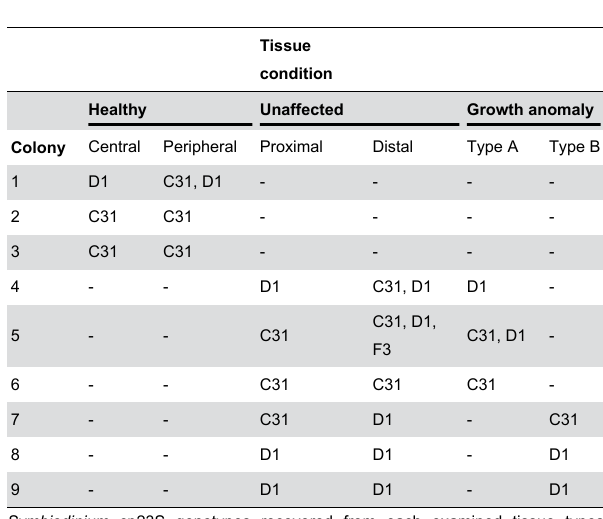
Table 1. Symbiodinium genotype